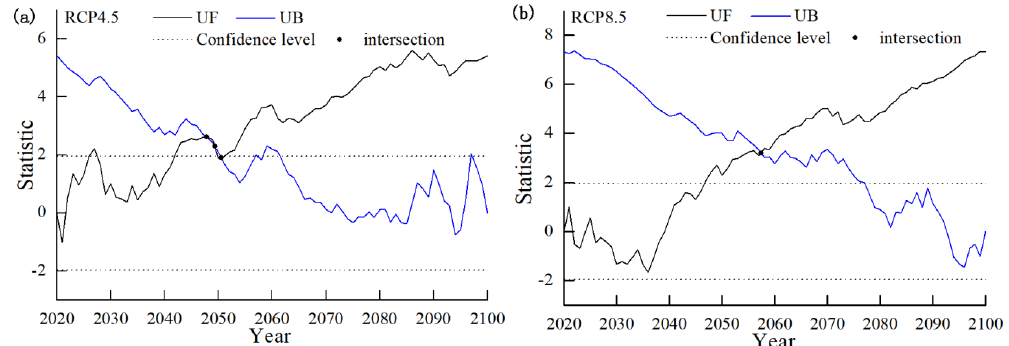
Figure 6. Mann–Kendall test of annual precipitation in the Lancang-Mekong River subregion under the RCP4.5 ( a ) and the RCP8.5 ( b ).